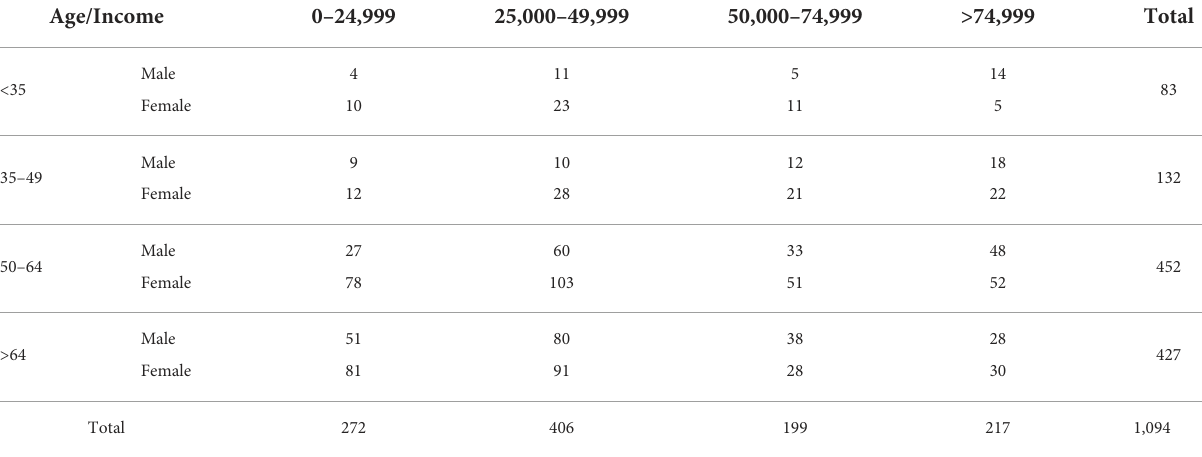
TABLE 2 The user numbers of sociodemographic groups in the Virus Watch cohort. Age/Income